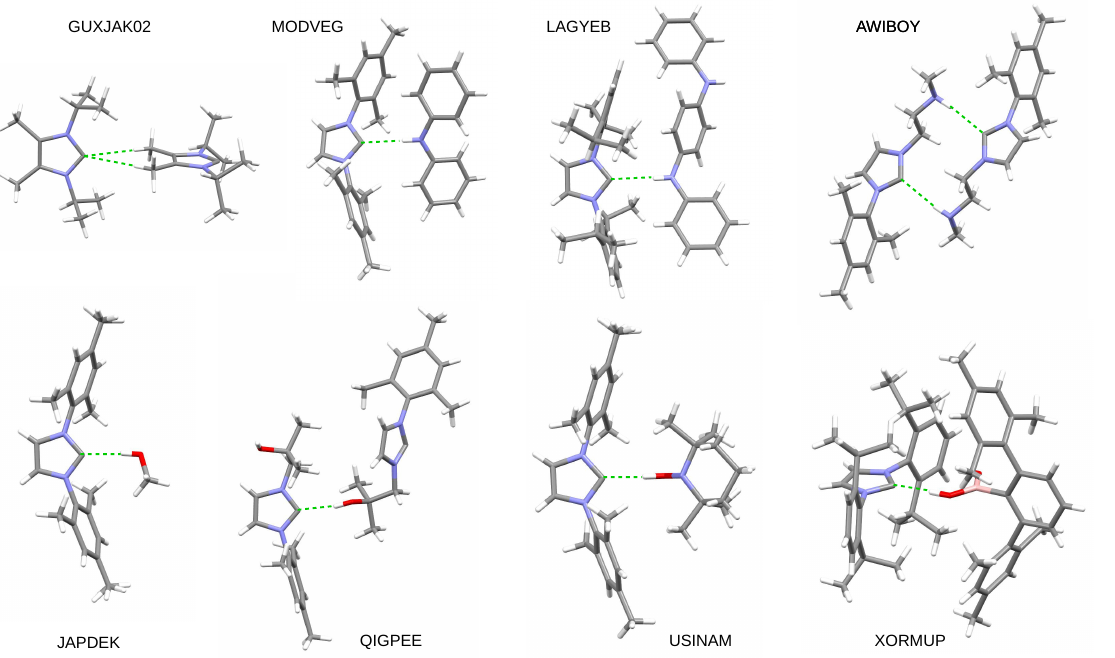
Figure 2. Examples of the occurrence of hydrogen bonds (marked with a dashed green line) involving a carbene carbon atom in crystallographic structures. The atoms are labeled as follows: carbon—gray, hydrogen—white, nitrogen—blue, oxygen—red, and boron—pink.